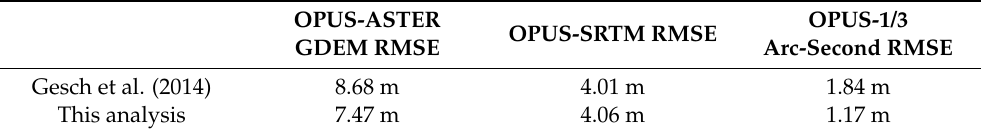
Table 19. Comparison of results of this study to Gesch et al.